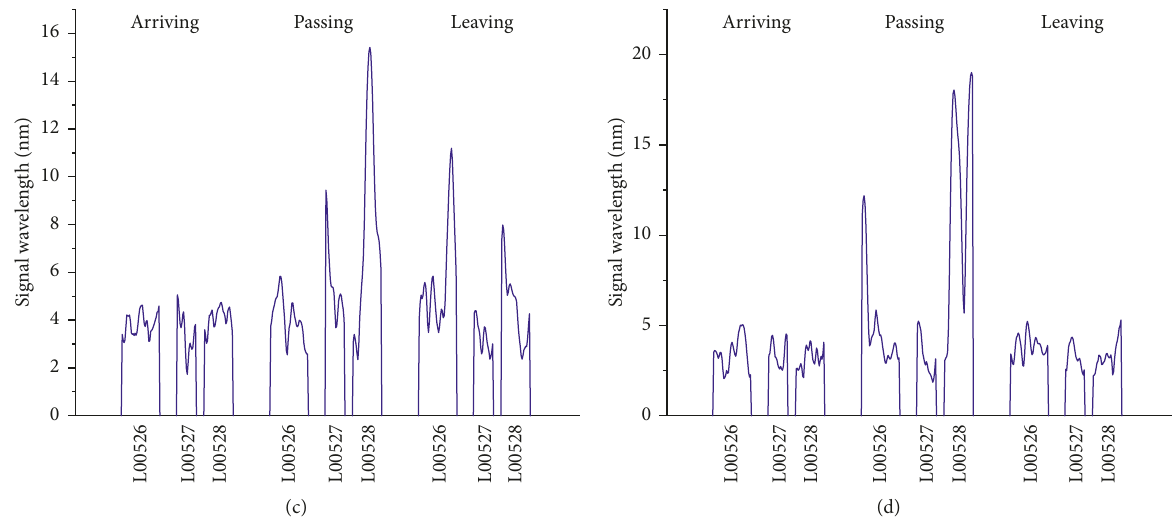
Figure 15: Vibration signal of the right track line after L00526 repair: (a) 1 st train; (b) 2 nd train; (c) 3 rd train; (d) 4 th train.